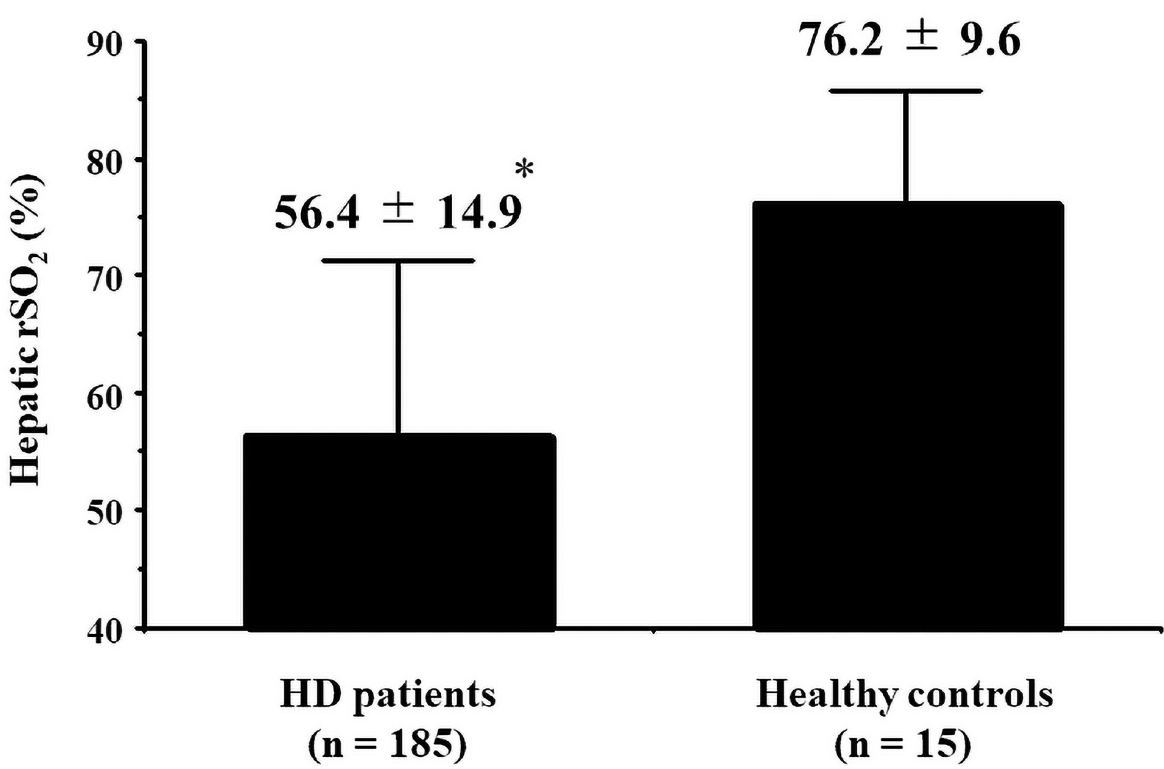
Fig 2. Comparison of hepatic rSO 2 between patients undergoing HD and healthy controls. Abbreviations: HD, hemodialysis; rSO2, regional saturation of oxygen. � p < 0.001 vs. healthy controls.